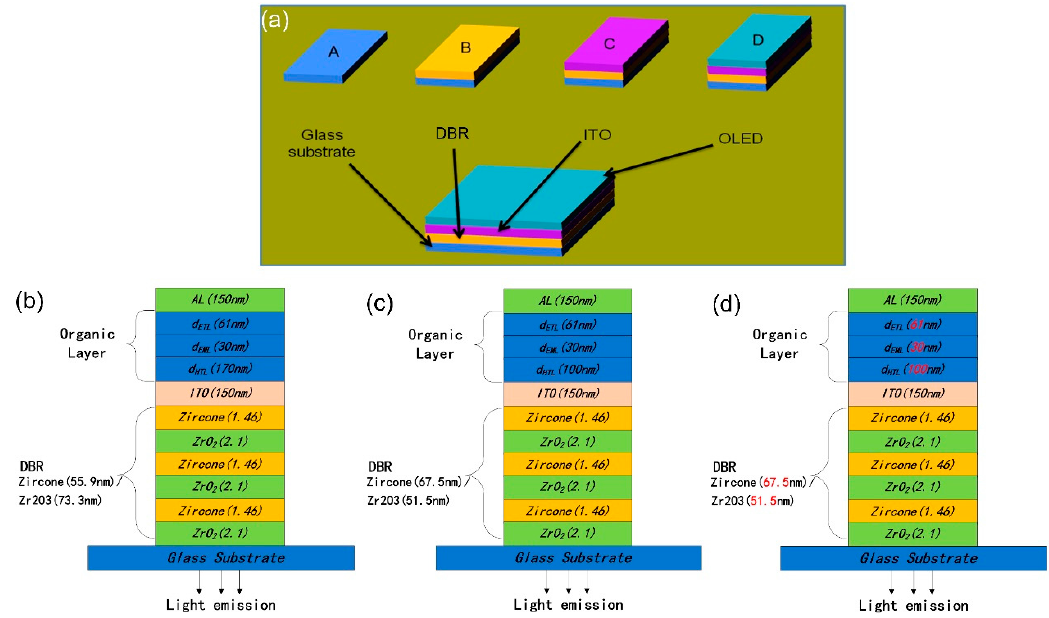
Figure 1. ( a ) Process of organic light-emitting diode (OLED) device fabrication; ( b ) structure of green OLEDs; ( c ) structure of blue OLEDs, and ( d ) structure of white OLEDs (WOLEDs).